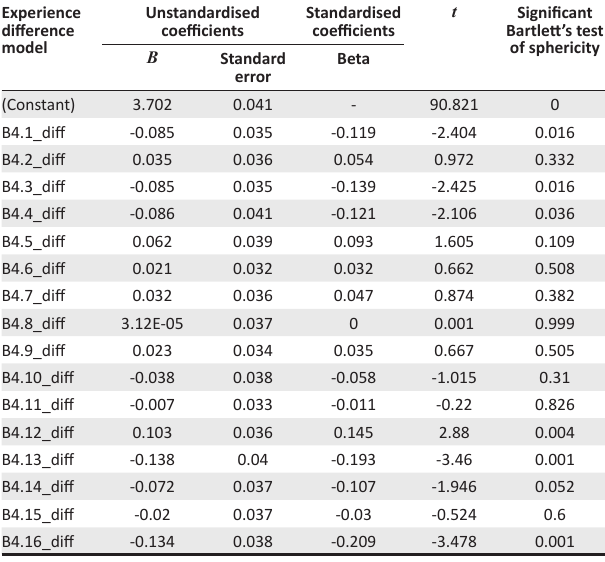
TABLE 4: Employee importance and employee current experience model on talent retention ( F = 17.278 [16, 694], p - value <